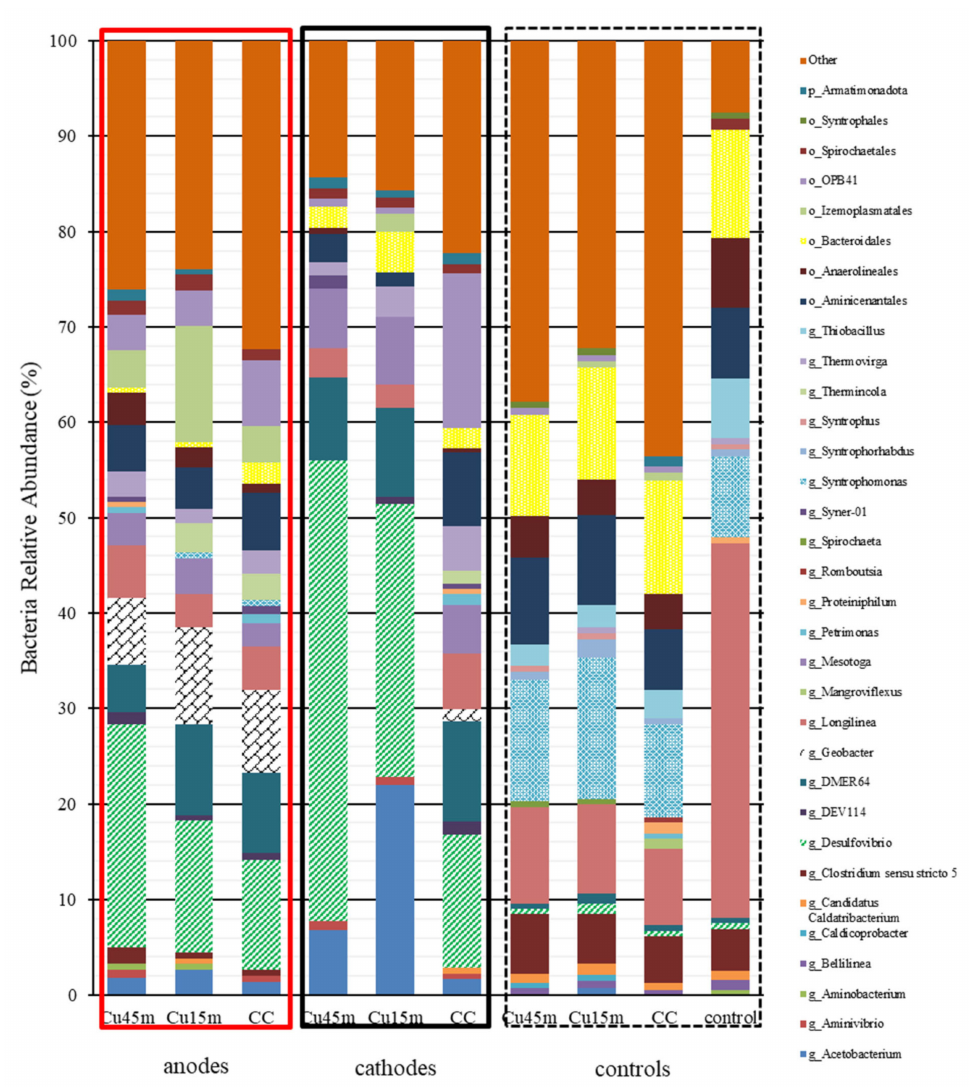
Figure 11. Bacteria relative abundance % at a genus level. Genus had a relative abundance <0.5% were assigned to “others”. Sample nomenclature: Cu45min: Carbon cloth deposited with copper nanoparticles for 45 min, Cu15min: Carbon cloth electrode deposited with copper nanoparticles for 15 min, CC: carbon cloth electrode, Control: serum bottle inoculated with anaerobic granular sludge no